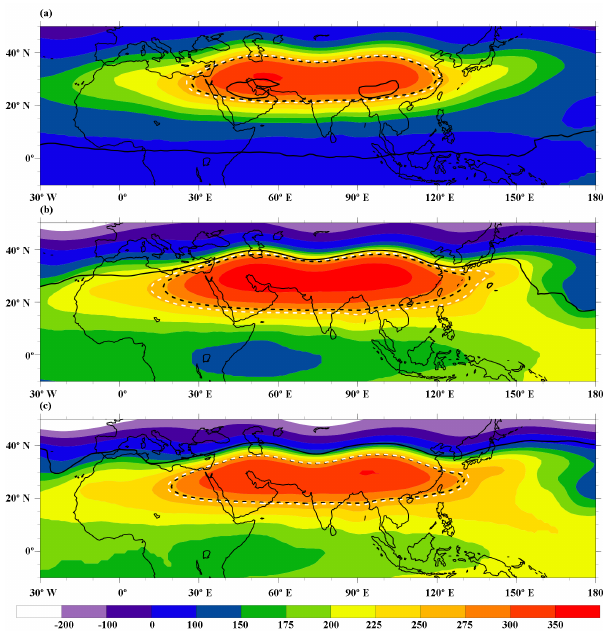
Figure 9. Longitude–pressure cross sections of GC simulated O 3 net production rates averaged over 23–29 ◦ N in (a) June, (b) July, (c) August and (d) September 2009. The black arrows correspond to the O 3 fluxes and the white solid lines to the 100pptv NO x con- tours from GC. The dashed black line corresponds to the tropopause (2 PVU), the grey solid line to upward convective mass fluxes of 2.5kgm − 2 s − 1 at 200hPa and the black solid line to the AMA boundary computed as the 270m GH anomaly (see text for